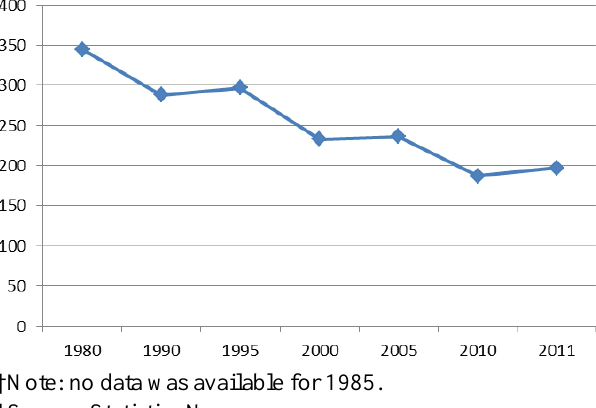
Fig. 2 . Population numbers for the village of Senja,